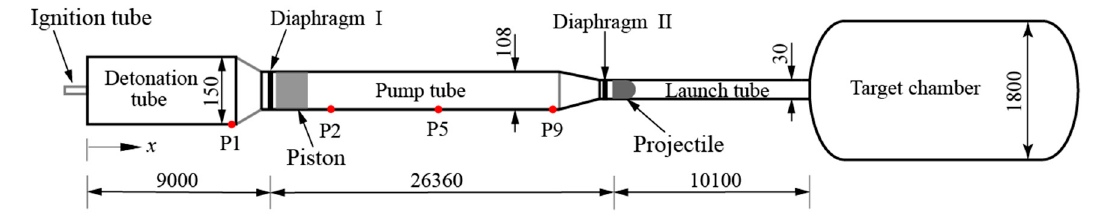
Figure 1. Schematic diagram of the two-stage light gas gun (not to scale, units in mm).